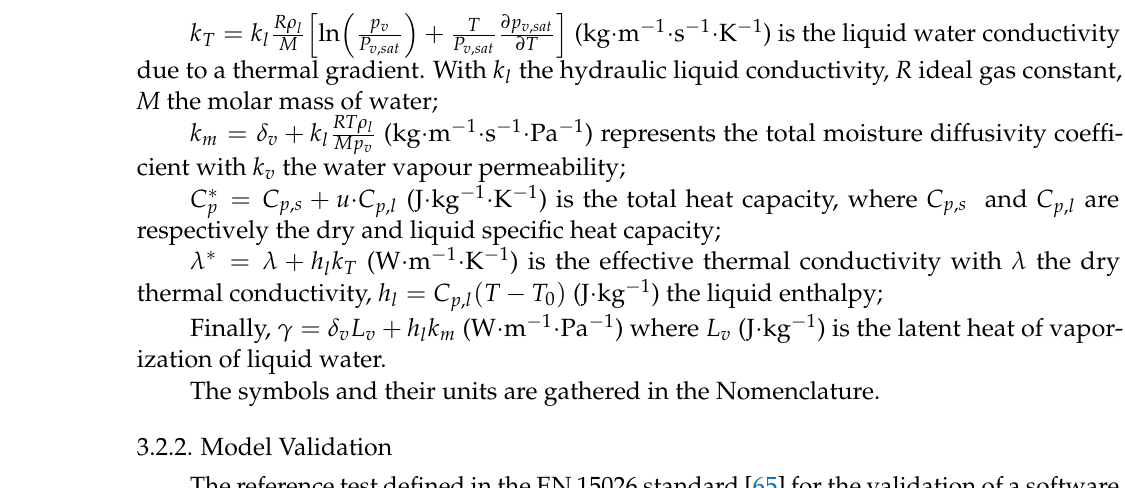
Table 2. Hygrothermal properties of the studied materials.